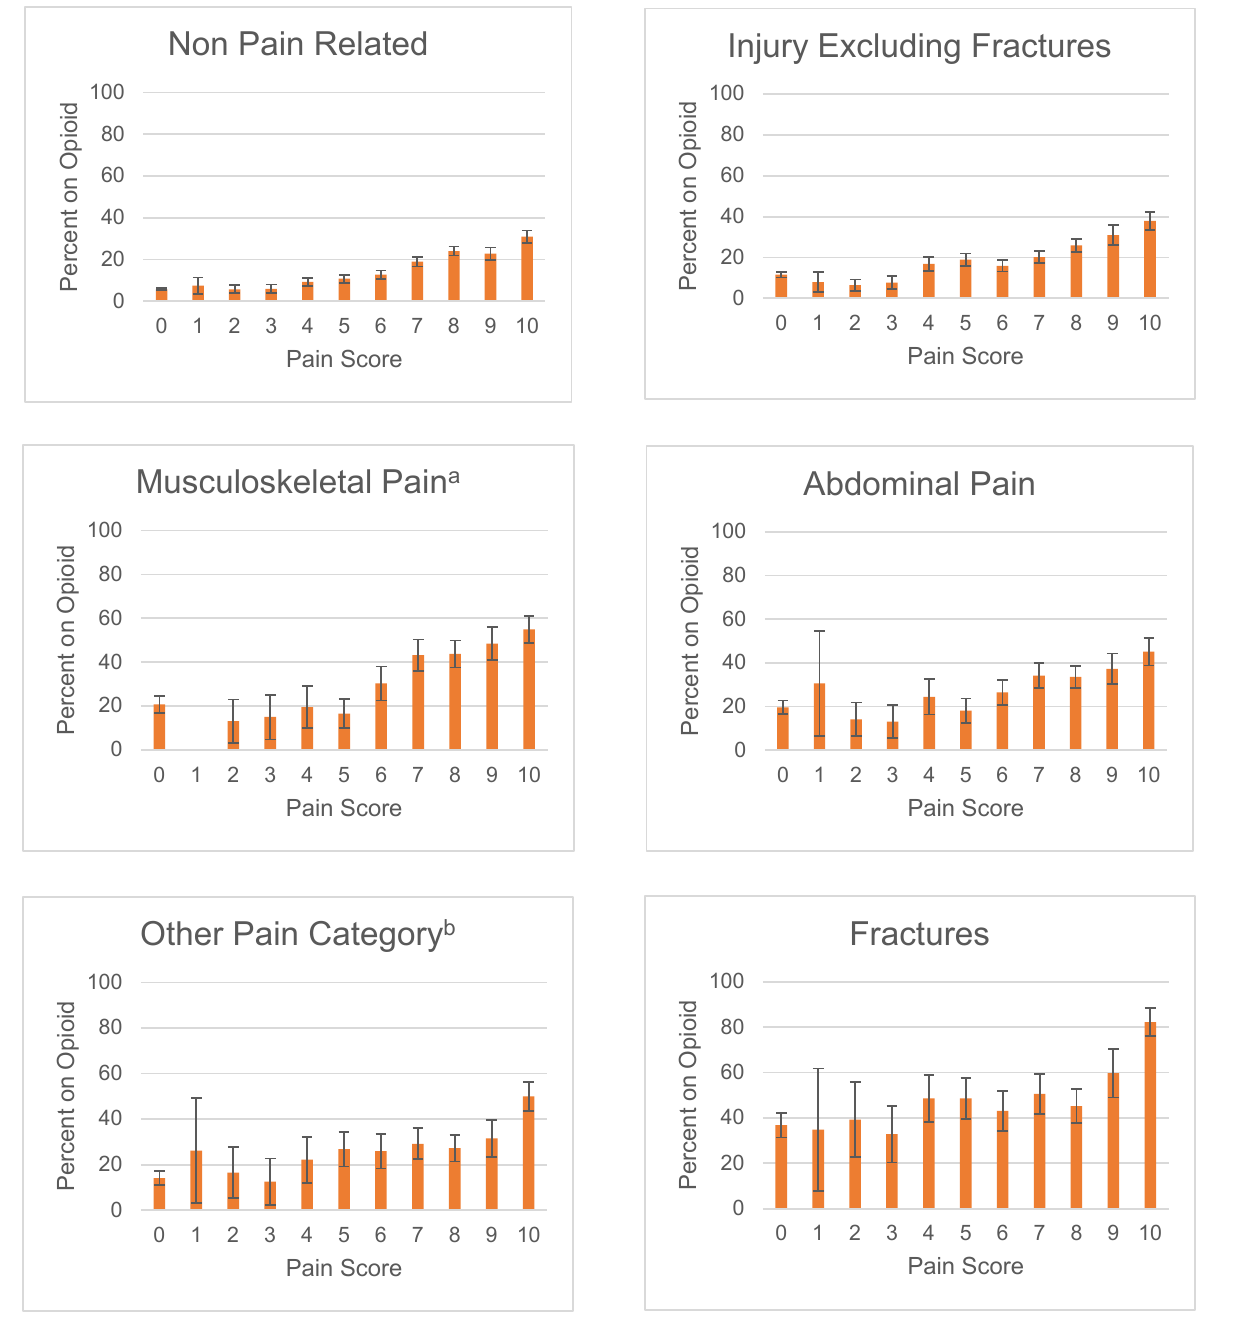
Figure 2. Proportion of Adolescent Opioid Use in the ED by Pain Score by Diagnosis. Calculated using a 95% confidence interval. a Musculoskeletal Pain includes arthritis/joint pain, pelvic pain, back pain, and neck pain. b Other Pain Category includes cancer-related pain, chest pain, cholelithiasis, headache, nephrolithiasis, sickle cell anemia, dental or jaw pain, fibromyalgia, and peripheral neuropathy.